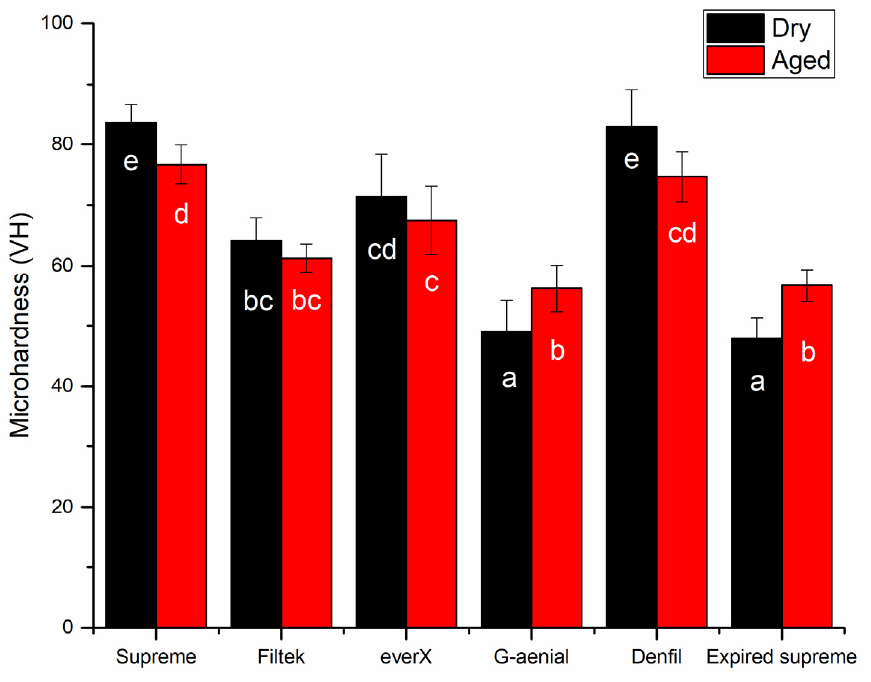
Figure 2. Bar graph showing means surface microhardness (VH) with standard deviations (SD) of tested resin composites. Non-statistically relevant variations ( p > 0.05) between the materials are represented by the same letters within the bars.